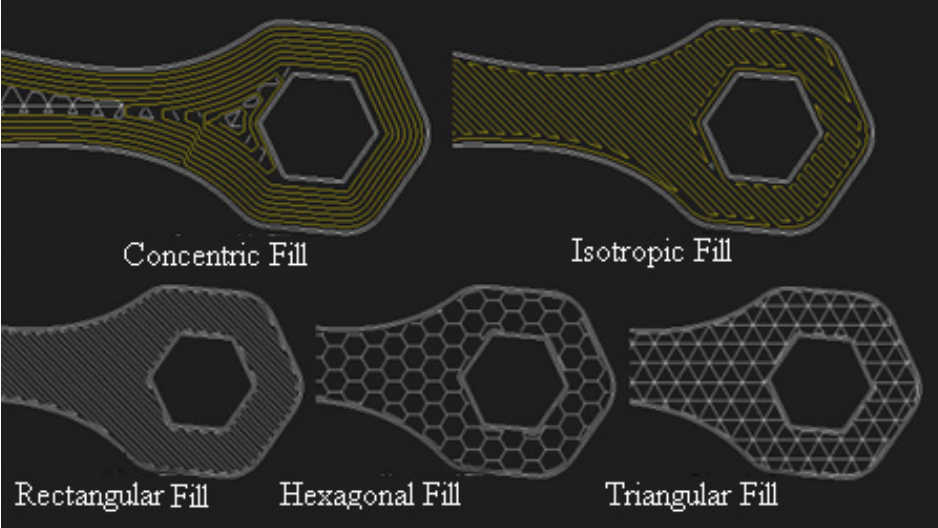
Figure 1. Schematic of the 3D printing process on the Markforged Two printer. Adapted from [2].